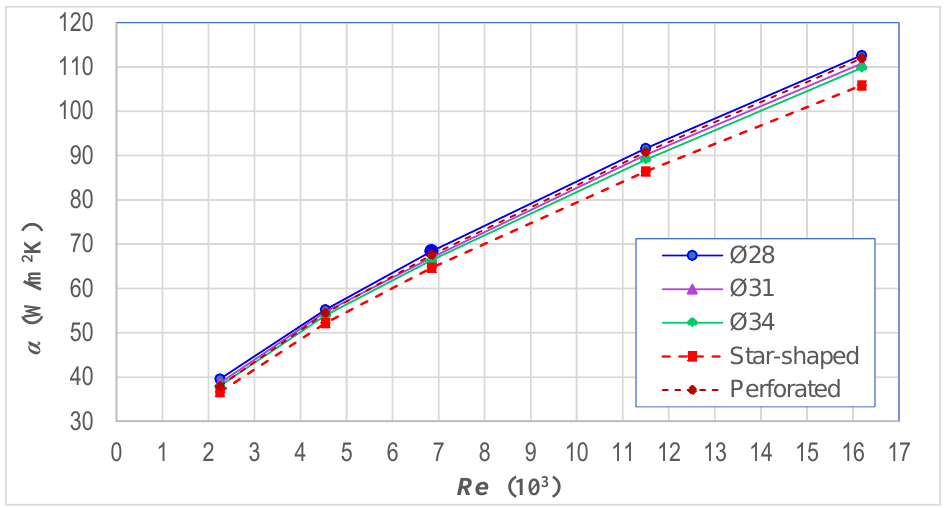
Figure 13. Heat transfer coefficient versus Re number.